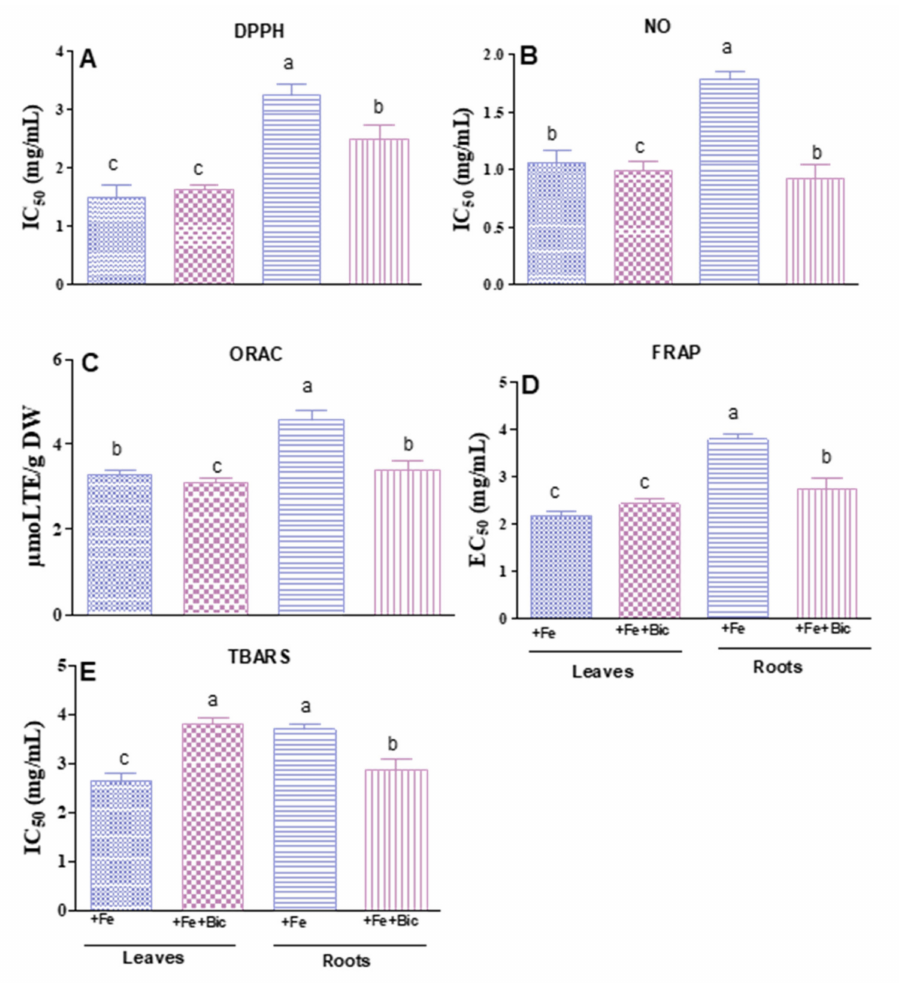
Figure 6. Capacity of hydromethanolic extracts of fennel leaves (L) and roots (R) of fennel plants cultivated under Fe sufficiency (+Fe) or under Fe deficiency conditions (+Fe + Bic) to scavenge the radicals 2,2-diphenyl-1-picrylhydrazyl (DPPH, A ), nitric oxide (NO, B ) and peroxyl (ORAC, C ), to reduce ferric Fe to ferrous form (FRAP, D ) and to inhibit lipids oxidative damage (TBARS, E ). Data represent the mean ± standard deviation of three independent assays. Values with different superscripts are significantly different at p <